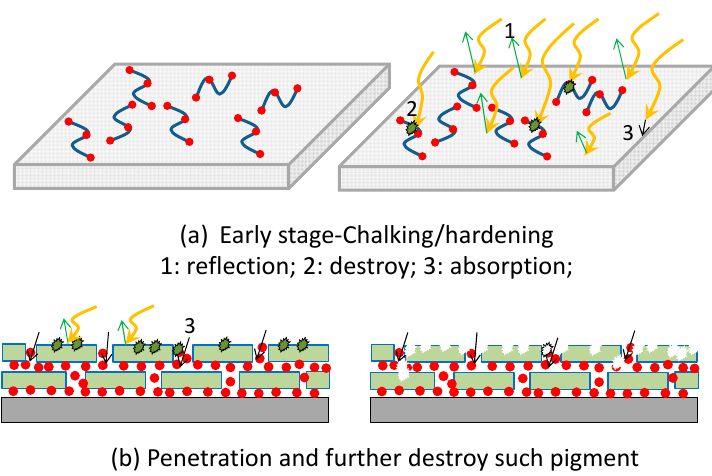
Figure 18. Deterioration mechanism of FRP materials caused by UV exposure.